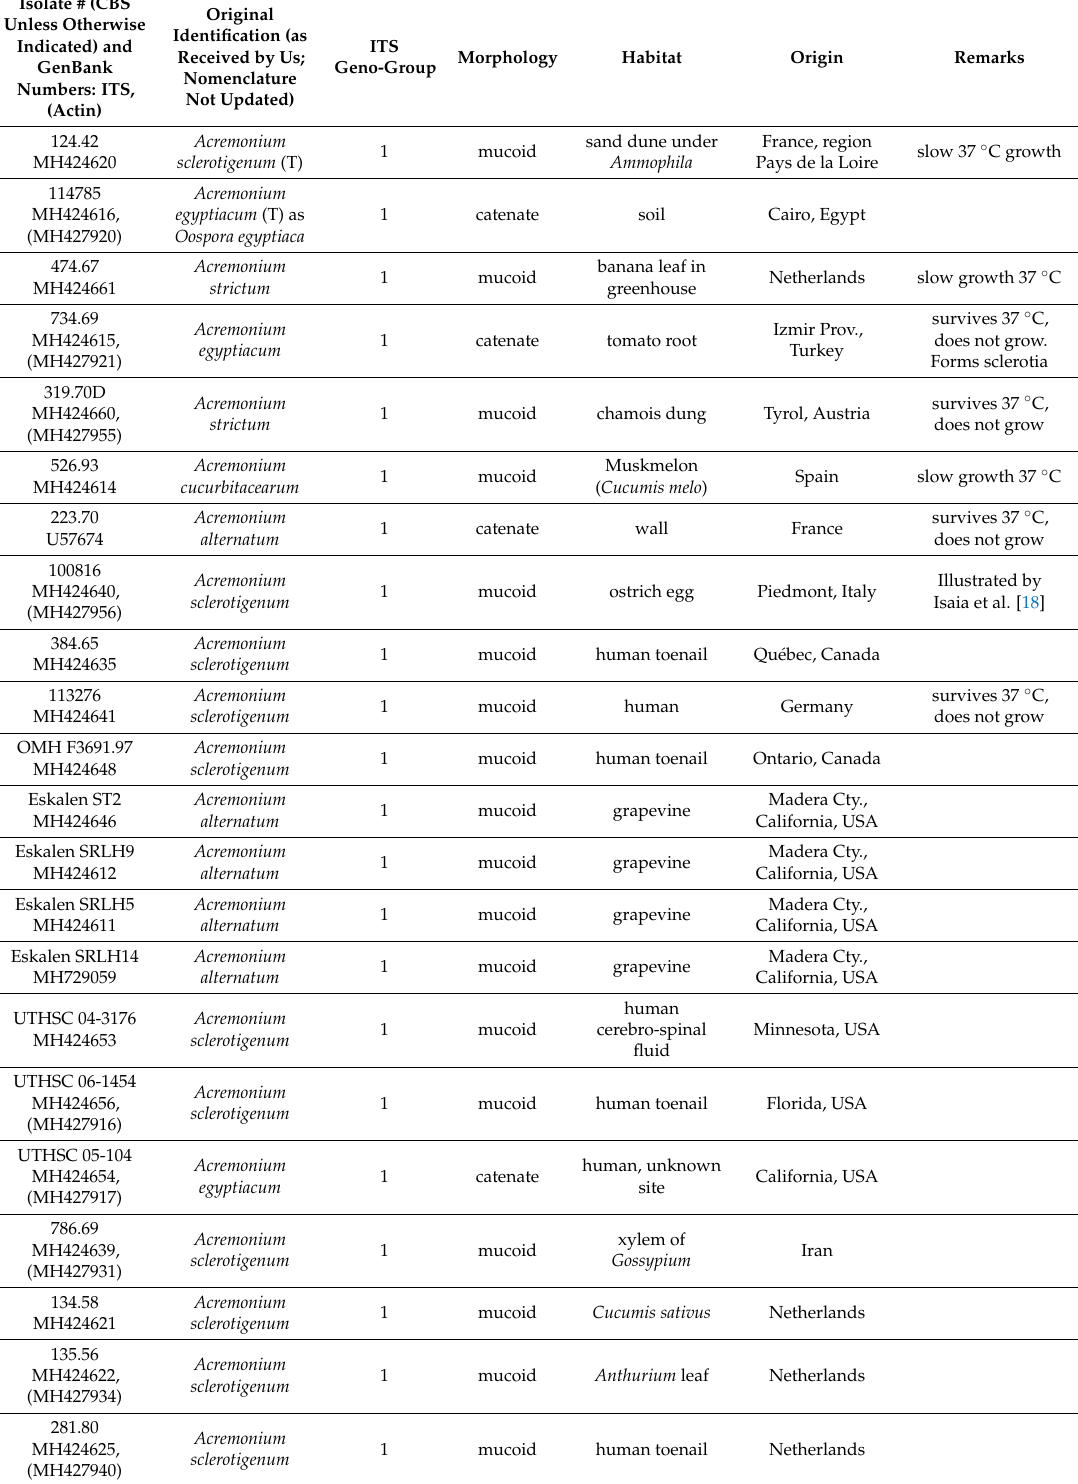
Table 2. Isolates in the Acremonium sclerotigenum / egyptiacum complex typed by ITS barcode type. Isolate # (CBS Unless Otherwise Indicated) and